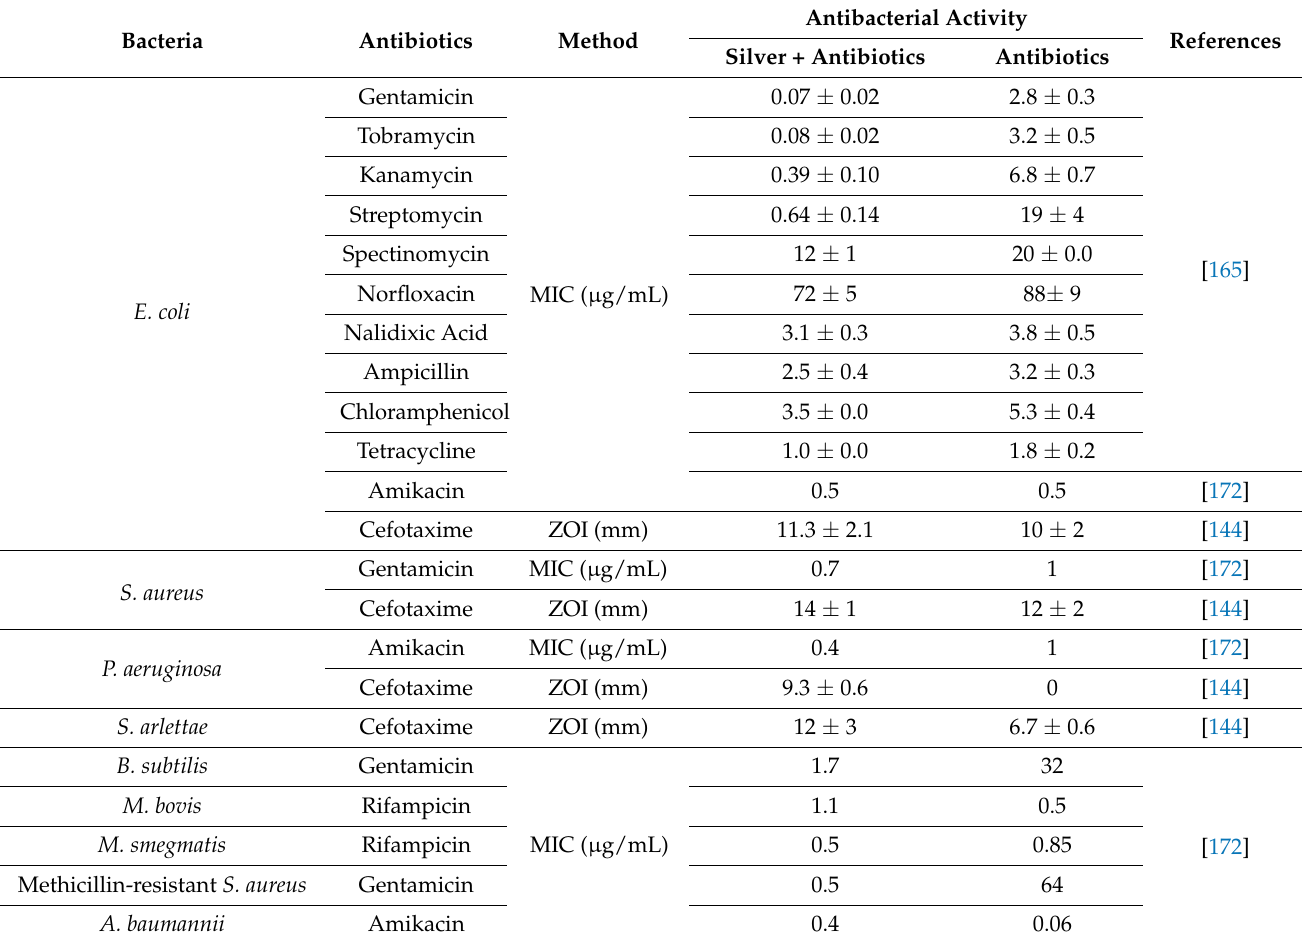
Table 2. Synergetic effects of silver ions complexed with